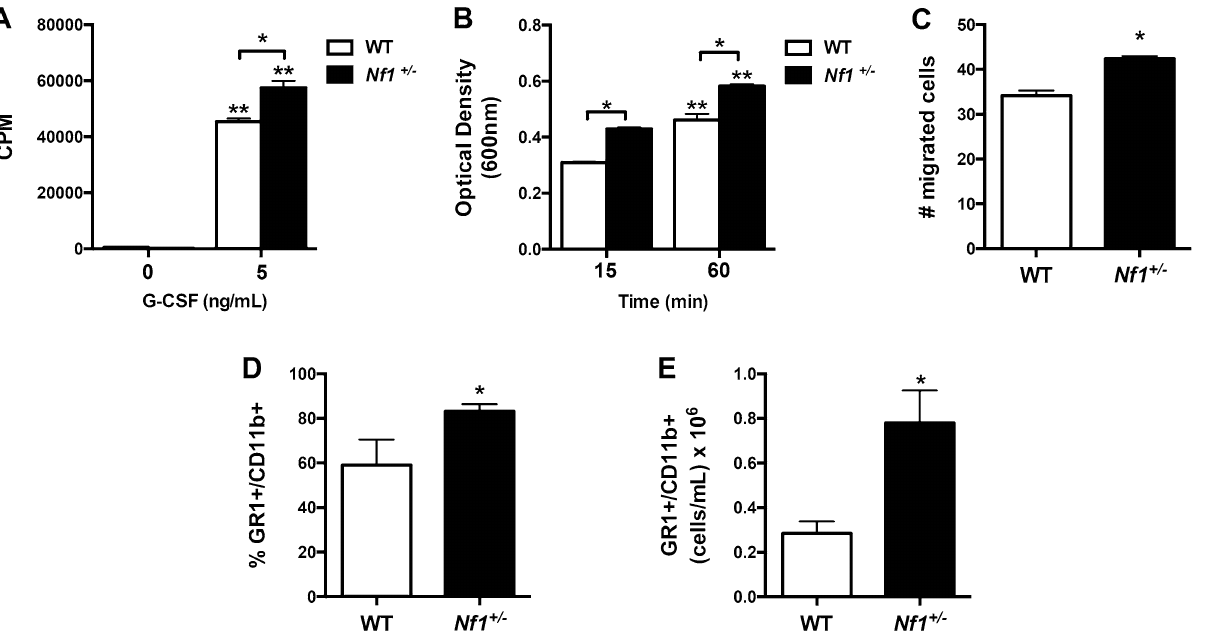
Figure 1. Neurofibromin controls neutrophil function in vitro and in vivo. ( A–C ) Quantification of WT (white bars) and Nf1 +/– (black bars) neutrophil proliferation ( A ), adhesion ( B ), and migration ( C ) in response to G-CSF. ( A ) Data represent thymidine incorporation reported as mean counts per minute (cpm) ± SEM, n = 4–5. * P < 0.01 for WT versus Nf1 +/– neutrophils. ** P < 0.001 for WT and Nf1 +/– neutrophils without growth factor versus WT and Nf1 +/– neutrophils incubated with G-CSF. ( B ) Data represent mean optical density (600 nm) ± SEM, n = 4–5. * P < 0.001 for WT versus Nf1 +/– neutrophils at each time point. ** P < 0.001 for WT and Nf1 +/– neutrophils at 15 min versus WT and Nf1 +/– neutrophils at 60 min. ( C ) Data represent mean number of migrated cells ± SEM, n = 4–5. * P < 0.01 for WT versus Nf1 +/– neutrophils. ( D and E ) Quantification of percent ( D ) and absolute number ( E ) of GR1 + /CD11b + neutrophils in peritoneal lavage fluid 48 h after LPS injection. ( D ) Data represent mean percent ± SEM, n = 4–5. * P < 0.01 for WT versus Nf1 +/– mice. ( E ) Data represent mean number of cells per mL ± SEM, n = 4–5. * P < 0.001 for WT versus Nf1 +/– mice. Analysis by 2-way ANOVA and Student’s t